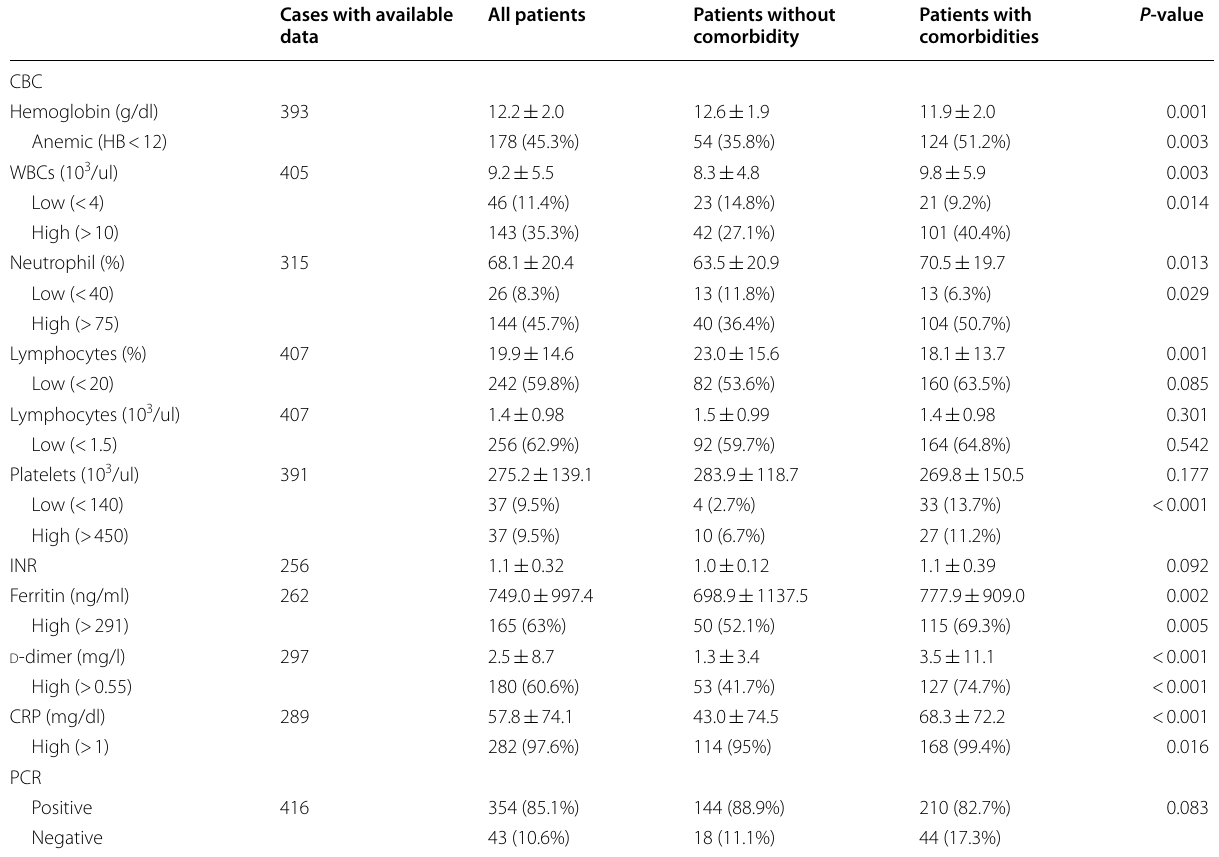
CBC: complete blood picture; WBCs: white blood cells; INR: international normalized ratio; PCR: polymerase chain